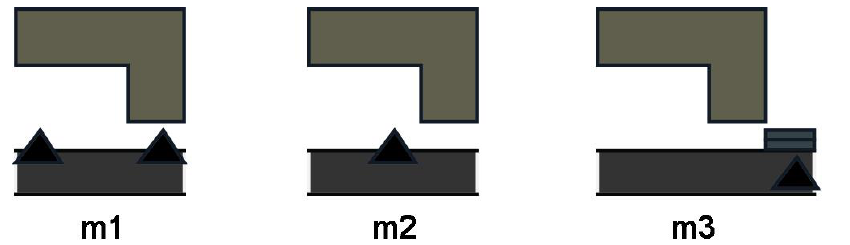
Figure 8. Location of the main gate in the plan (D) Reprinted/adapted with permission from Ref. [3]. 2018, Donghwa Shon: When the main gate is on a different elevation, the facade consists of outer walls and windows without a gate (d1). And when there is a gate, the gate is located on the same line as the wall (d2) or on the setback from the wall line (d3).